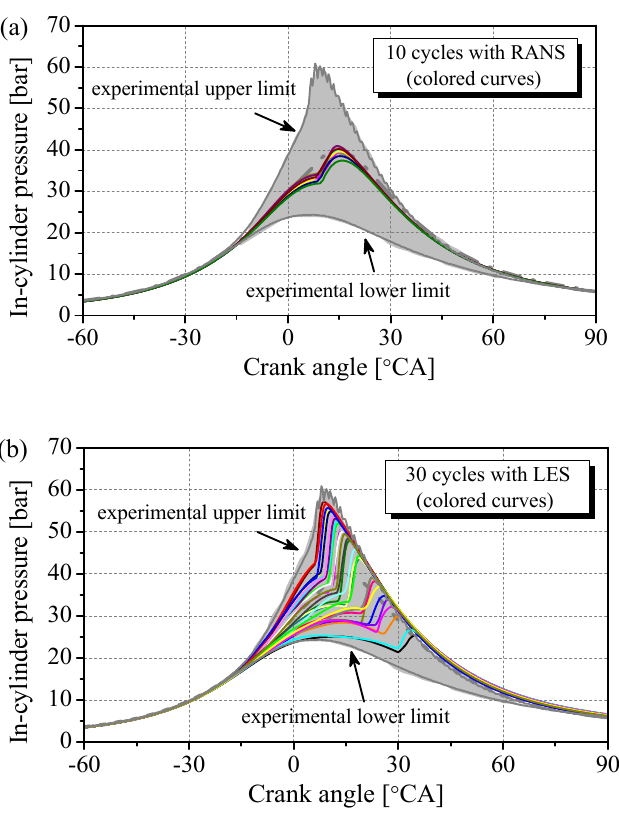
Figure 2. In-cylinder pressure traces from ( a ) 10 cycles RANS simulations and ( b ) 30 cycles LES simulations against experimental measurements (grey envelop).